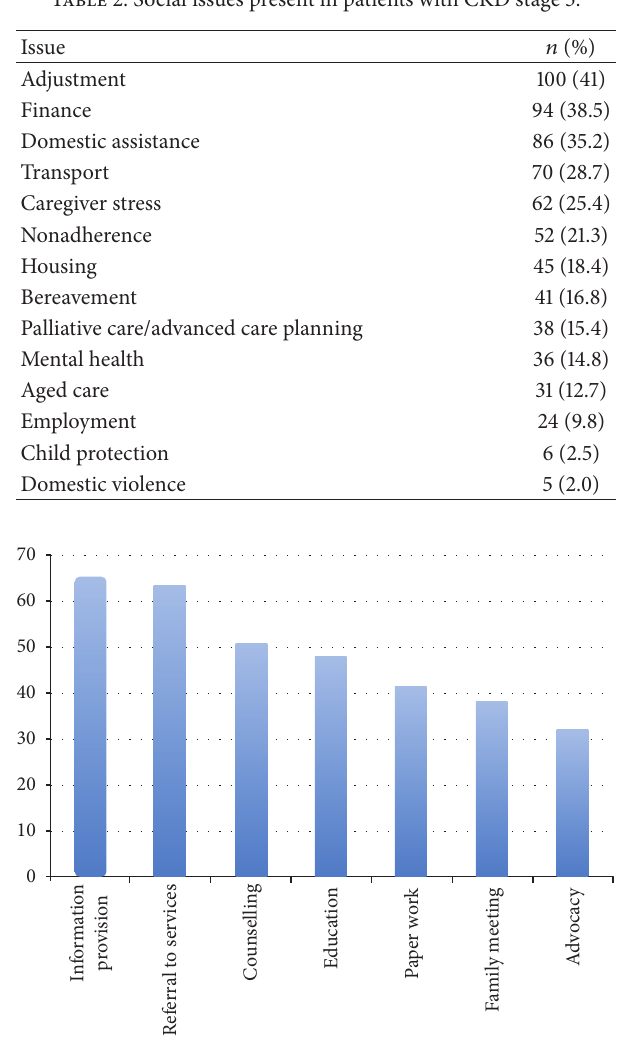
Figure1:Breakdownofsocialworksupportservicesasapercentage. Allpatientsreceivedinitialpsychosocialassessment(notincludedin